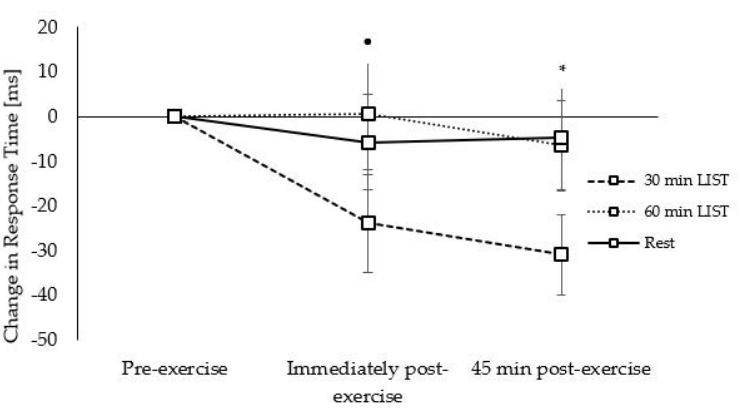
Figure 9. Change in response times across the morning on the 30 min LIST, 60 min LIST, and resting control trials on the incongruent level of the Flanker task. Faster response times following 30 min LIST vs. rest *; p < 0.05. Tendency for faster response times following 30 min vs. 60 min LIST • ; p = 0.073.